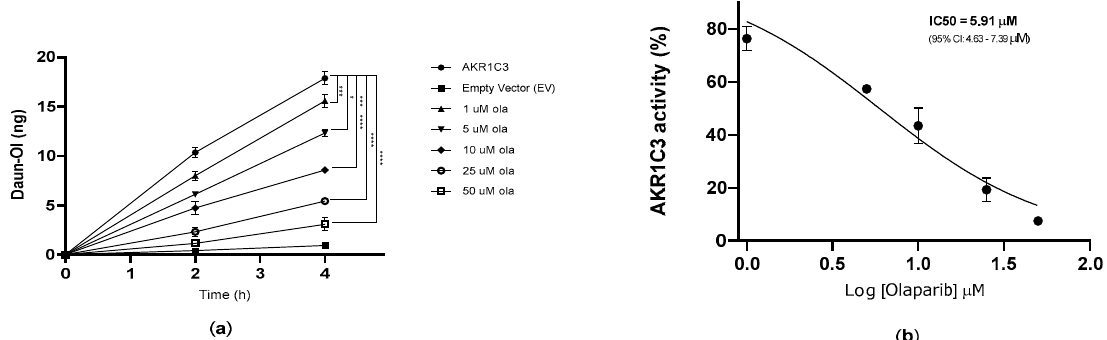
Figure 5. ( a ) Effect of olaparib on AKR1C3-mediated intracellular daunorubicin (Daun) metabolism in HCT116 cells. Statistical analysis was performed with end-point data, using one-way analysis of variance (ANOVA) followed by Dunnett’s post-hoc test (* p ≤ 0.05, *** p ≤ and **** p ≤ 0.0001, compared to AKR1C3 control). ( b ) IC 50 of AKR1C3 inhibition in HCT116 cells exposed to olaparib (1–50 µM). Data are expressed as the mean ± SD from three independent assays.